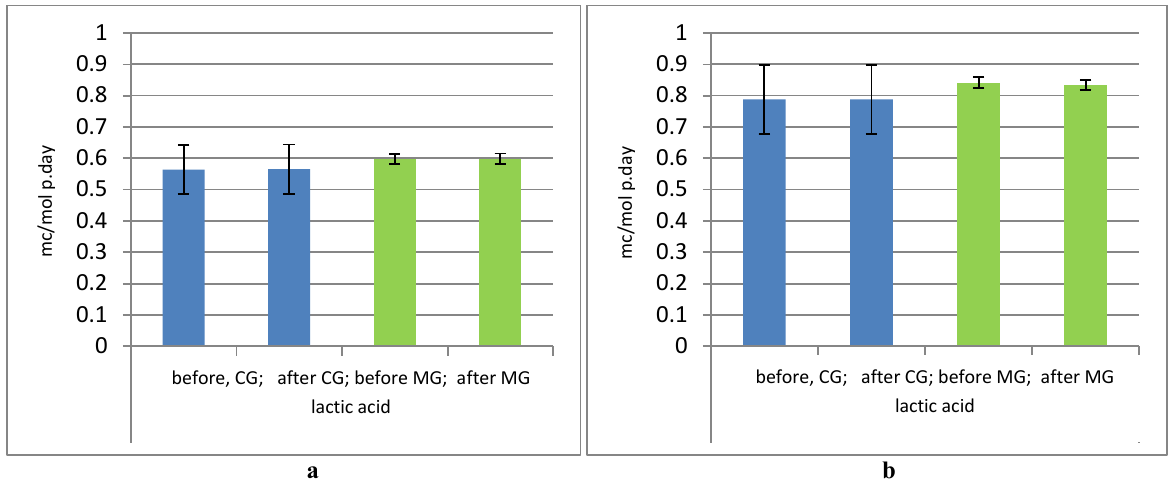
Fig.5. Indicators of bio-chemical monitoring by excretion of lactic acid before and after experiment in lactate cluster (of main and comparative groups): a) by bicycle stress test «Vita maxima»; b) by results of control special tests. (р ≥ 0.05). CG – comparative group, MG – main group.